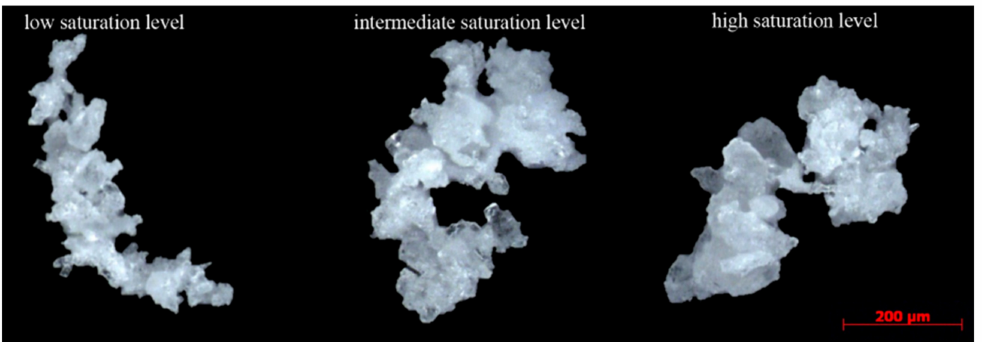
Figure 1. Granule morphology for different net rates of liquid addition; high saturation level means that the net rate of liquid addition to the granule is fast compared to dryingafter the work of Askarishahi et al. [10] (figure has been reused with the permission from the